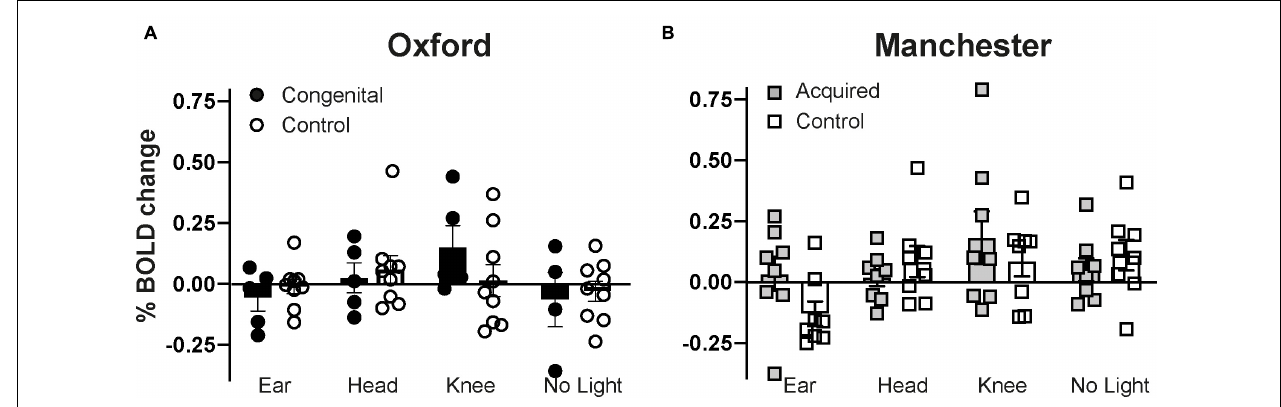
FIGURE 3 | Mean percentage BOLD signal change during each experimental condition (ear, head, knee, no light) extracted from the primary visual cortex (V1, as defined by the Juelich Histological Atlas in FSLview). Group mean values for each of the four experimental conditions are shown in (A) for Oxford and (B) for Manchester. Error bars represent standard